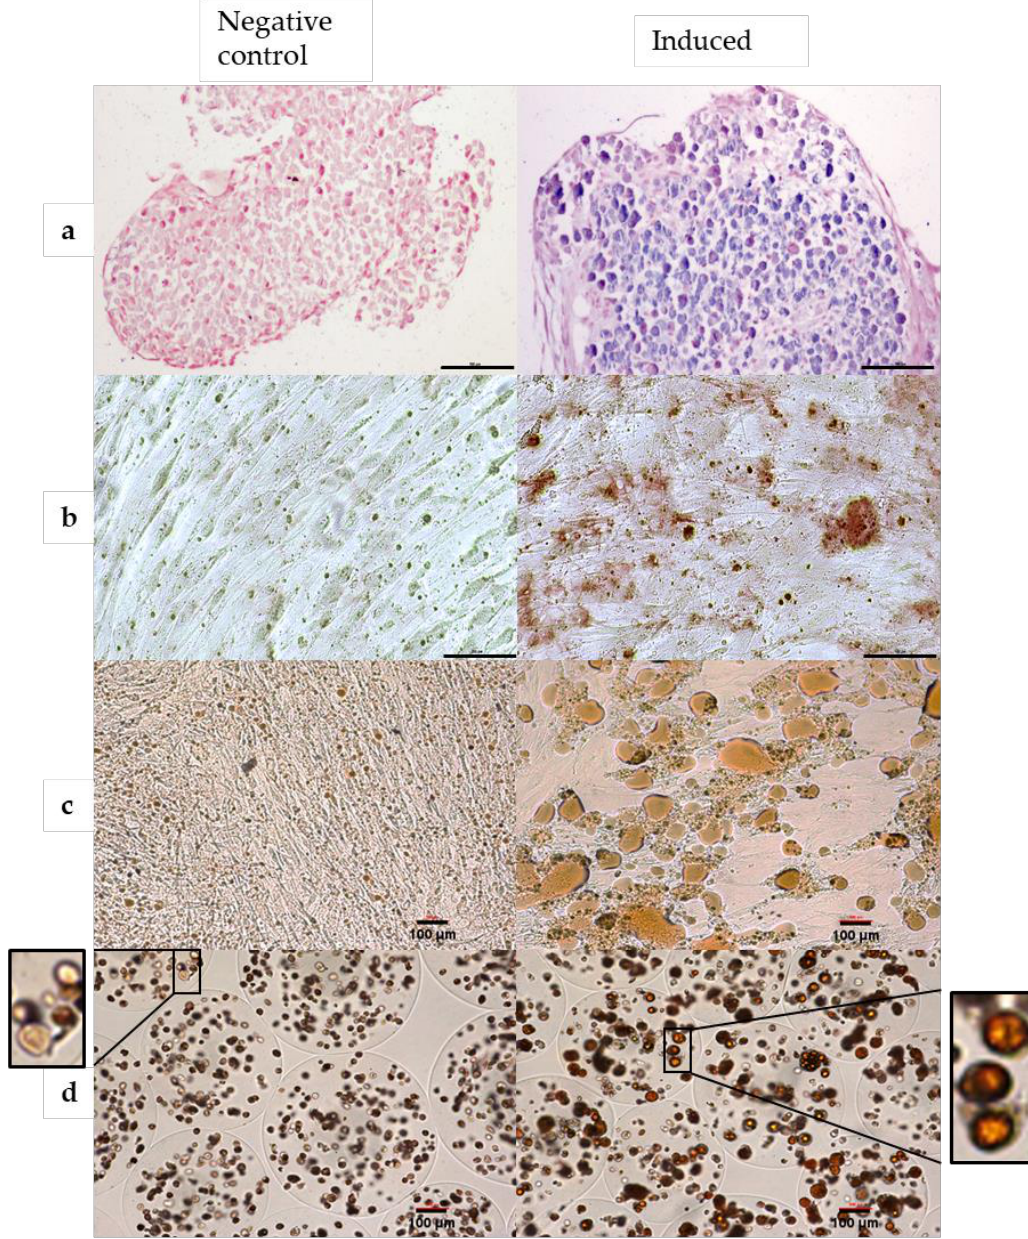
Figure 4. In vitro differentiation capacity of encapsulated ASCs assessed for the three recommended mesenchyme lineages. Scale bar: 100 µ m, 10 × magnification, optical microscopy with transmitted light. ( a ) Cells in condition 2, untreated (control) or treated (induced) with a chondrogenic induction medium for 21 days and stained with Alcian Blue which color in blue acid mucosubstances and acetic mucins. ( b ) cells in condition 2, untreated (control) or treated (induced) with an osteogenic induction medium for 21 days and stained with Alizarin Red, which color in red calcium deposit. ( c ) cells in condition 2, untreated (control) or treated (induced) with an adipogenic induction medium for 14 days and stained with Oil red O, which color lipids in red. ( d ) cells in condition 1, untreated (control) or treated (induced) with an adipogenic induction medium for 14 days and stained with Oil red O, which color lipids in red. The blow-up from the original picture on the sides show lipid vacuoles formed after ASC induction into adipocytes (on the right) and the absence of these vacuoles in the control sample (on the left).